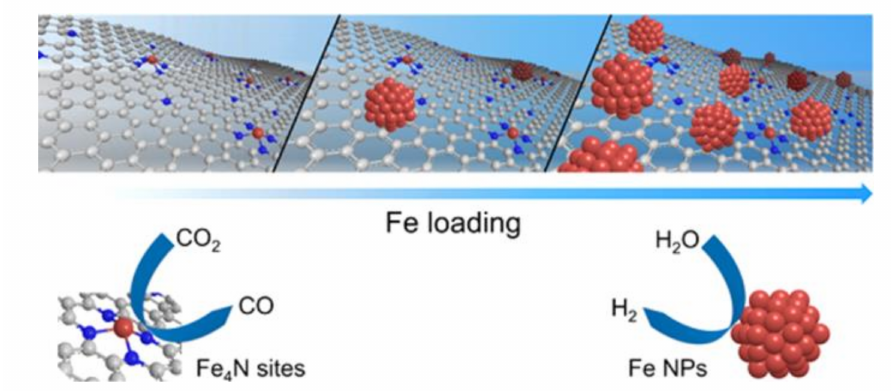
Figure 10. Schematic representation of the role of Fe-based catalyst in catalyzing either HER or CO 2 RR to CO as Fe loading on the carbon support changes. Reprinted with permission from Ref. [78]. Copyright 2022 American Chemical